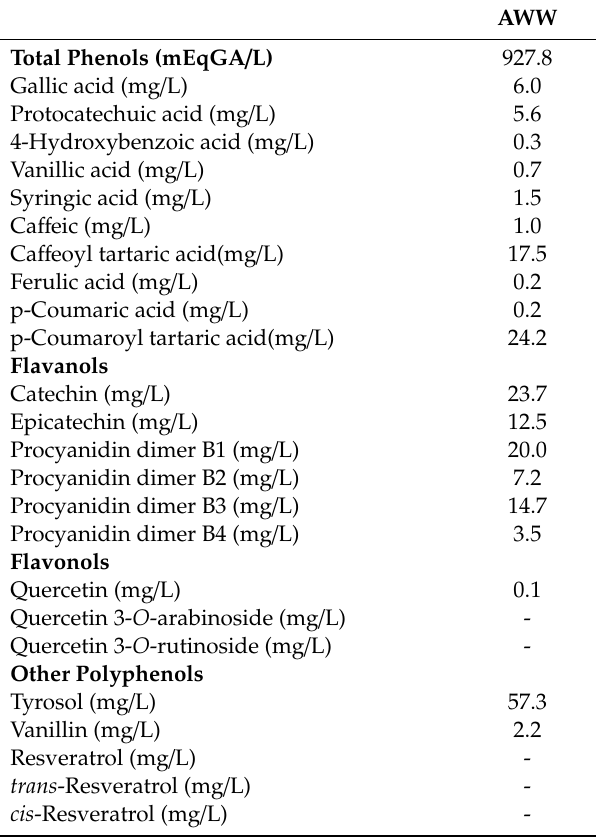
Table 1. Phenolic composition of the aged white wine